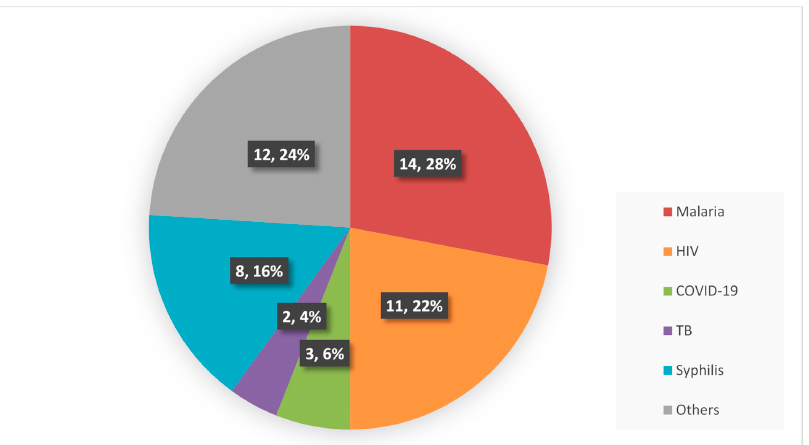
Figure 3. Distribution of the types of POC diagnostic tests in the articles included in the scoping review of supply chain management systems for point-of-care diagnostic services.